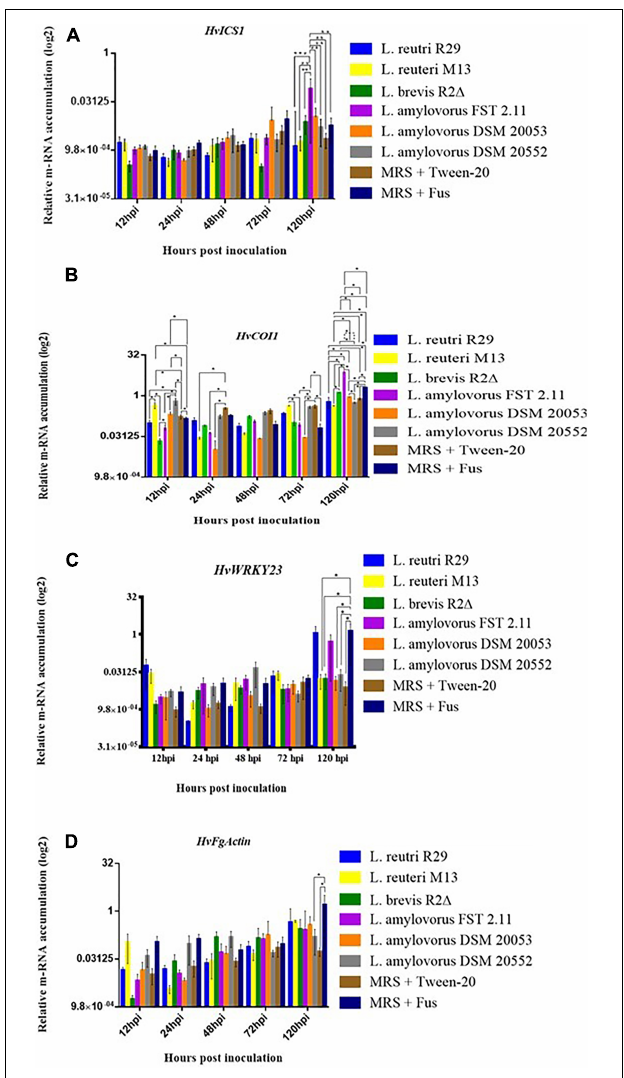
FIGURE 6 | Relative gene expression level in barley head tissue harvested at 12, 24, 48, 72, and 120 hpi of fungal inoculation. (A) HvICS1, (B) HvCOI1, (C) HvWRKY23 and (D) FgActin . Error bars indicate ± SEM ( n = 8). Asterisks show significant differences between expression levels (* P ,